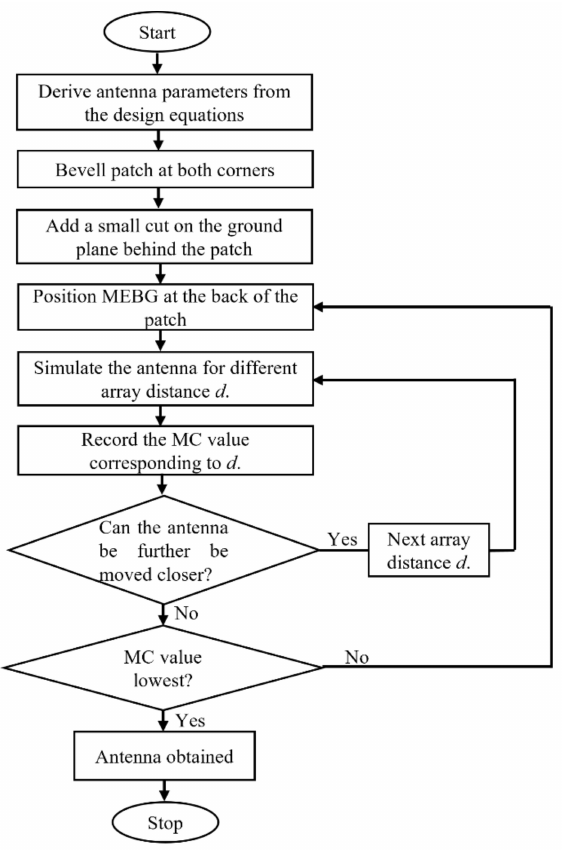
Figure 2. The flow chart of the mutual coupling reduction